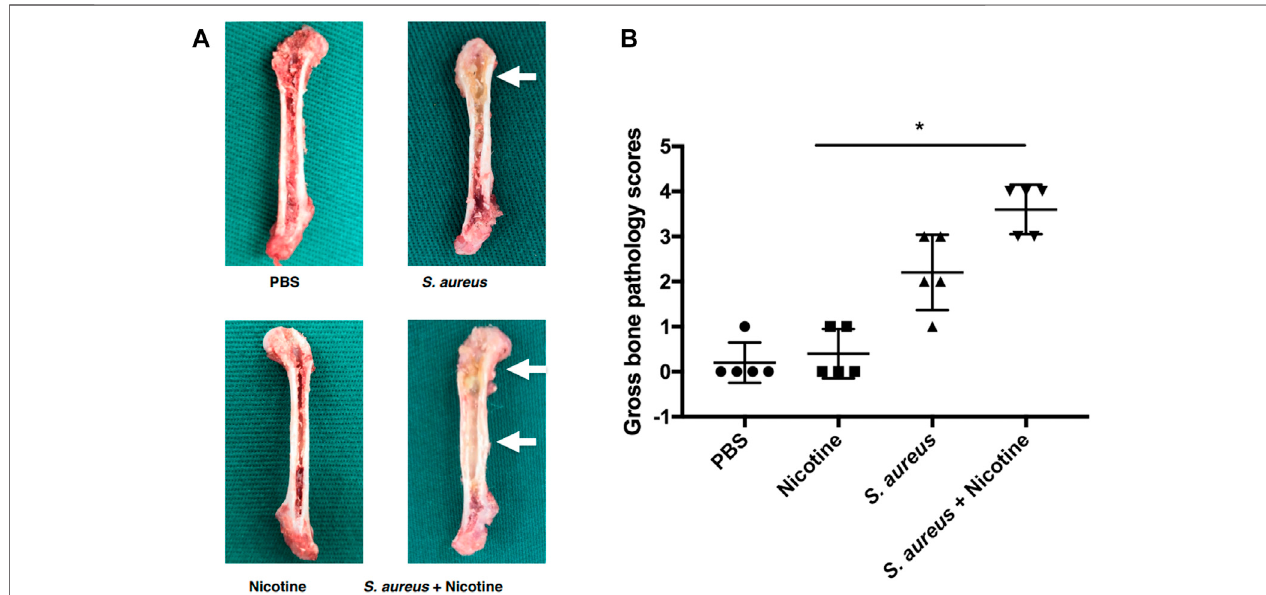
FIGURE 1 | Nicotine and S. aureus synergistically increased the gross bone pathology. (A) Gross appearance of the rat femurs three weeks after implantation. Abscess and widening of the shaft are pointed out with white arrows. (B) Gross bone pathology scores of rat femurs. * p < 0.05.